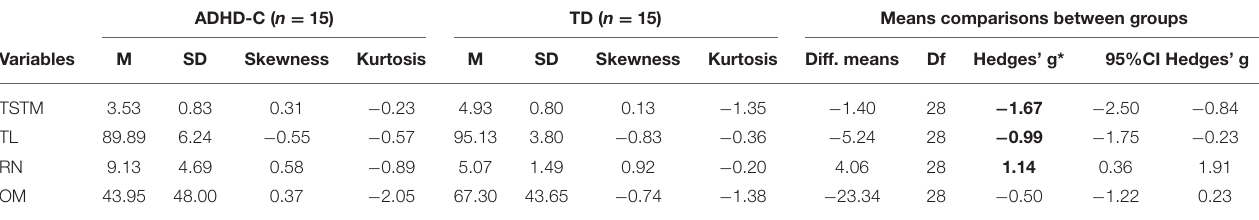
TABLE 2 | Hedges’ g-comparison between groups: diagnosis by the WalCT. ADHD-C ( n = 15) TD ( n = 15) Means comparisons between groups Variables M SD Skewness Kurtosis M SD Skewness Kurtosis Diff. means Df Hedges’ g* 95%CI Hedges’ g